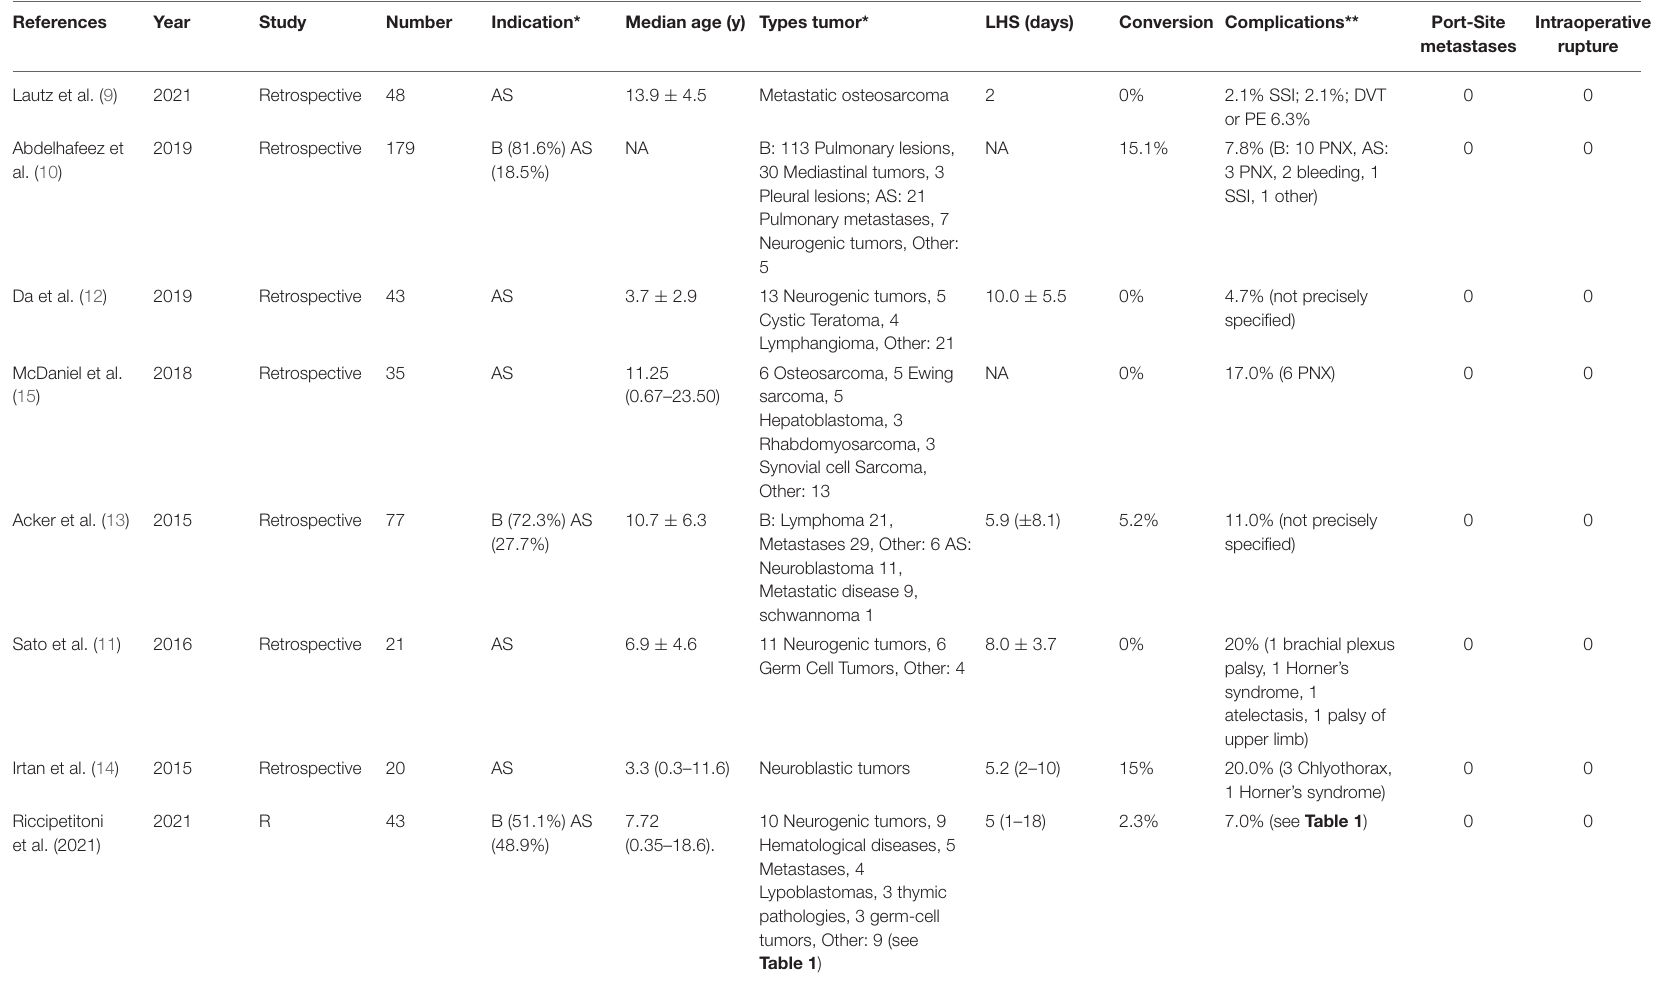
TABLE 2 | Review of the most recent